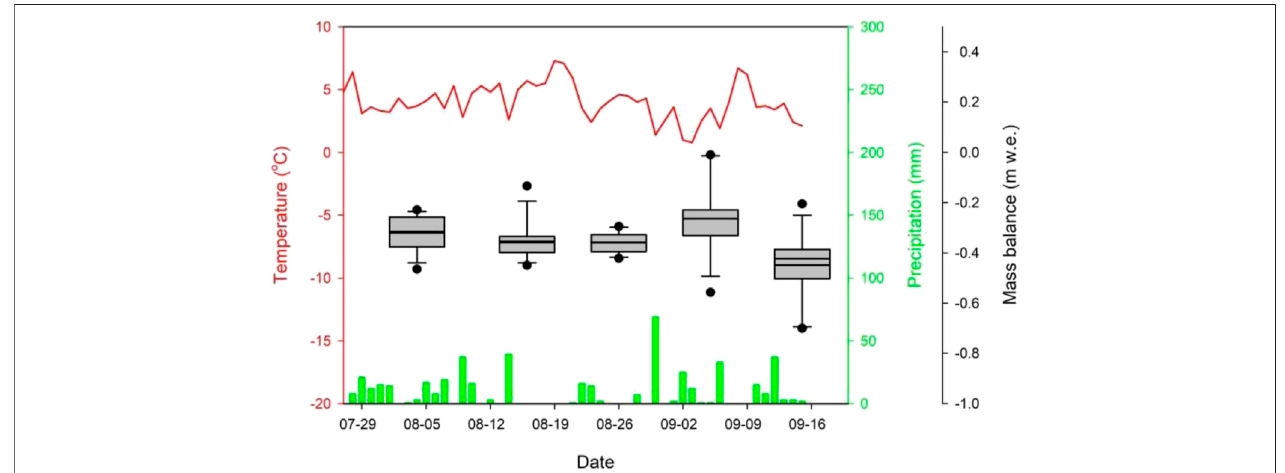
FIGURE8| Changesintheairtemperature,precipitation,andglaciermassbalanceduringtheperiodfromJuly27to15September2019.Theredlinedenotesthe daily air temperature at an elevation of 4,800 m s.l., the green bars denote the daily precipitation, and the boxes denote the mass balance at the stake points during the